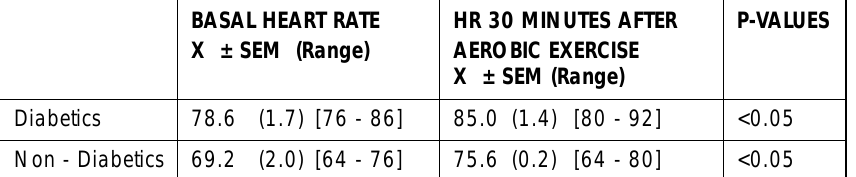
Table 2: Basal (Resting) Heart Rate (HR) and Heart Rate after 30 minutes period of rest